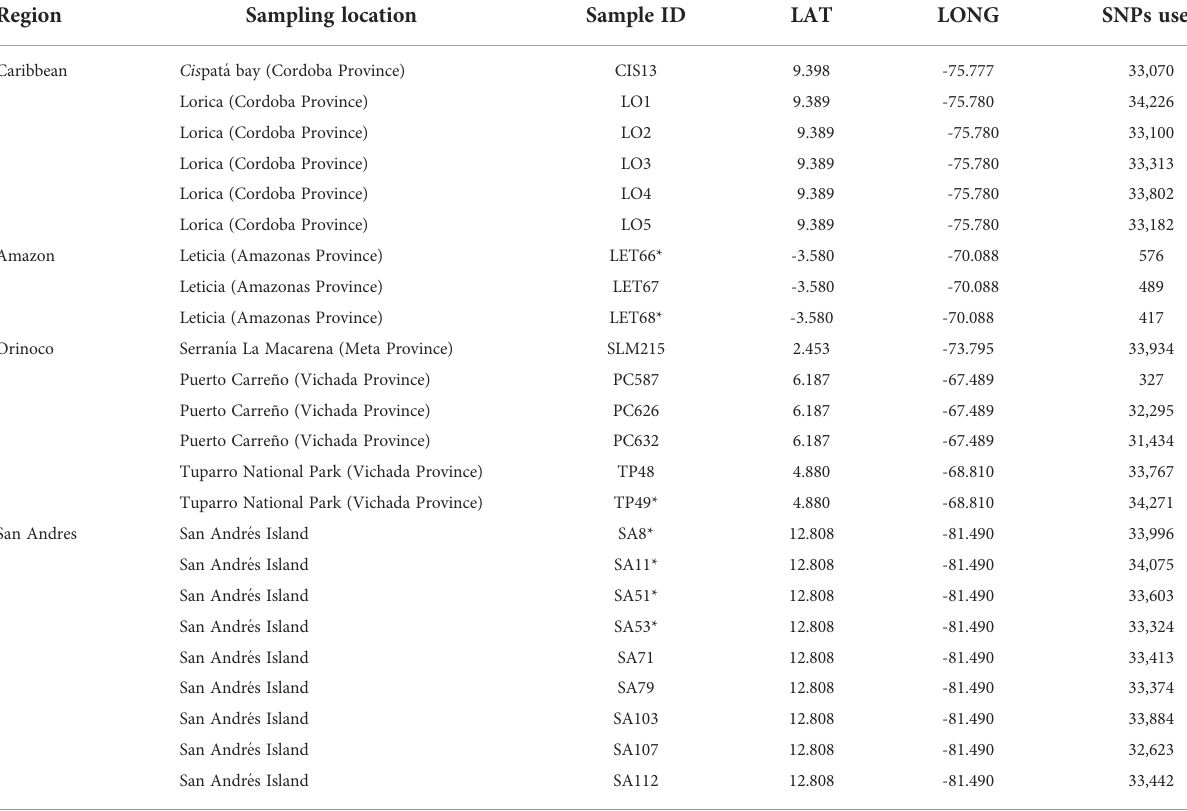
TABLE 1 Geographic region, location, sample ID, geographic coordinates and the total number of recovered SNPs for all samples included in this study.